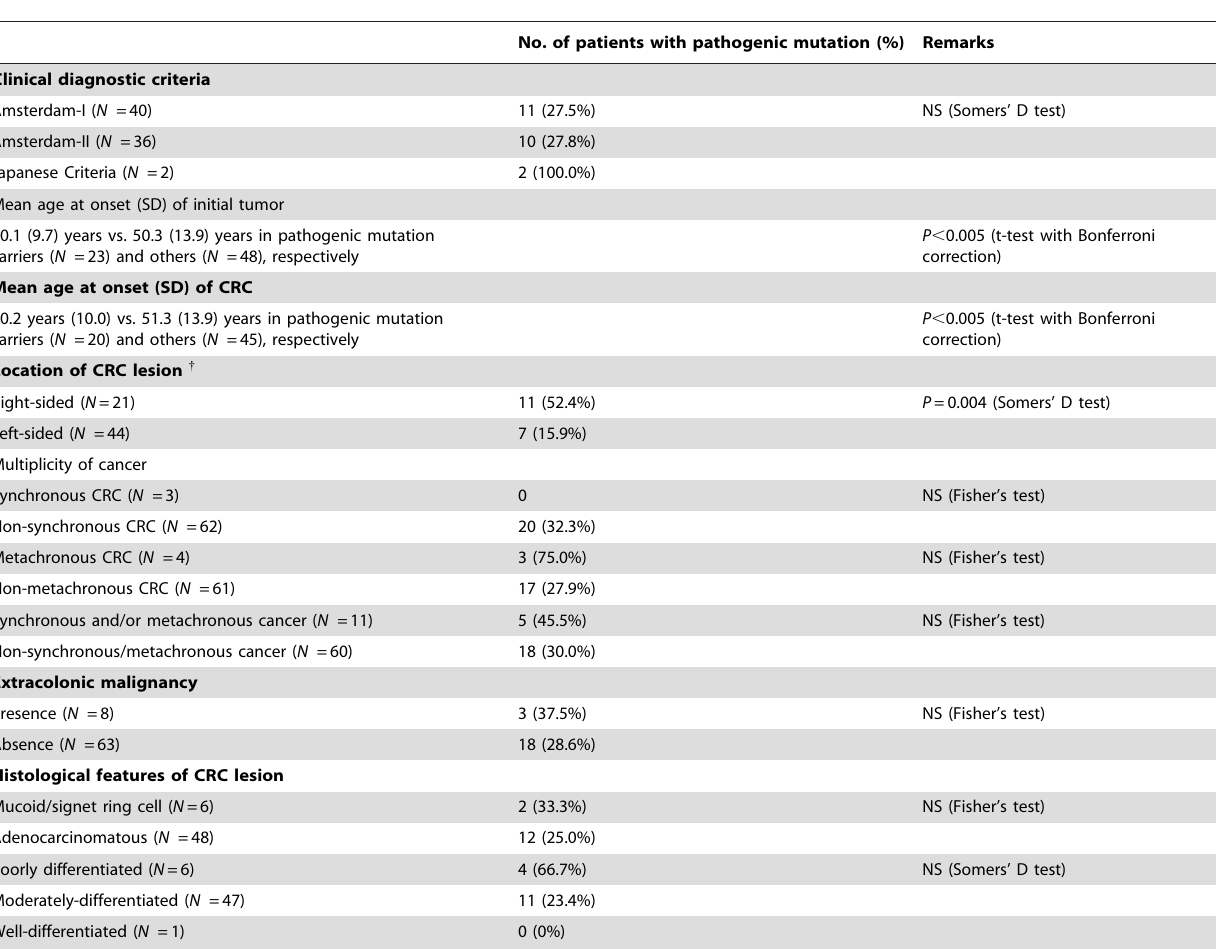
Table 3. Evaluation of cardinal clinico-pathological features of Lynch Syndromes (LS) as predictors of pathogenic germline